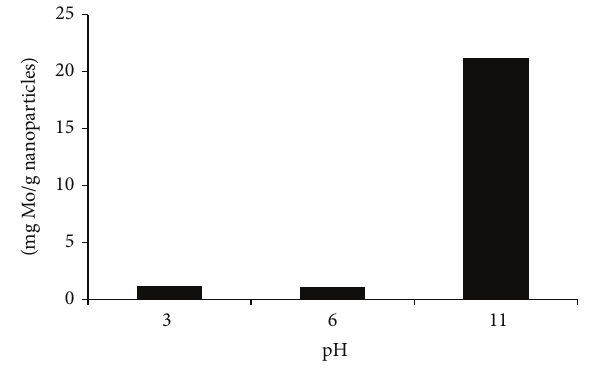
Figure 5: Inhibitor released as a function of pH, mg Mo/g nanopar-